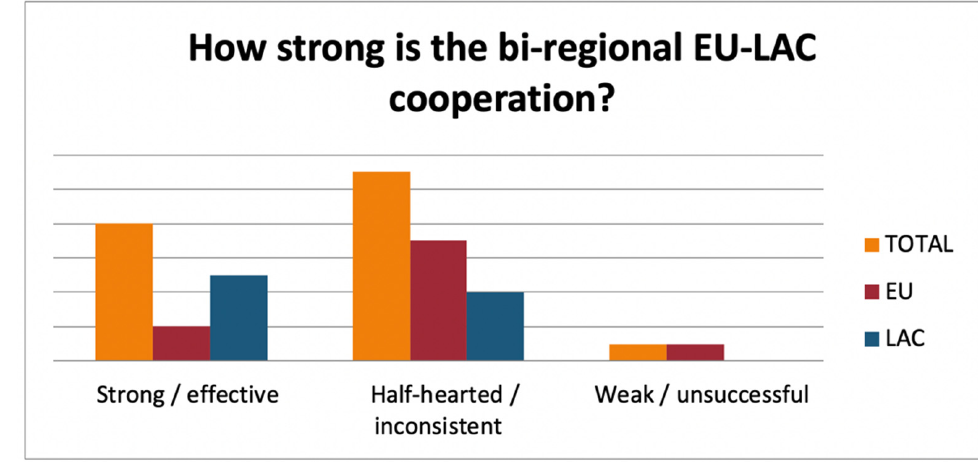
Figure 2. Strength of the bi-regional EU–LAC STI cooperation.